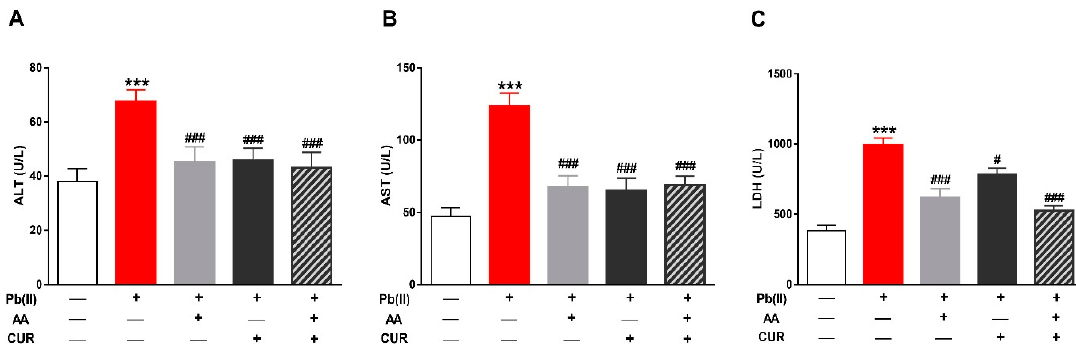
Figure 1. Curcumin (CUR) prevents Pb(II)-induced liver injury in rats. CUR, AA and their combination reduced serum alanine aminotransferase (ALT) ( A ), aspartate aminotransferase (AST) ( B ) and lactate dehydrogenase (LDH) ( C ) in Pb(II)-intoxicated rats. Data are expressed as mean ± SEM, ( n = 6). *** p < 0.001 versus Control. # p < 0.05 and ### p < 0.001 versus Pb(II).